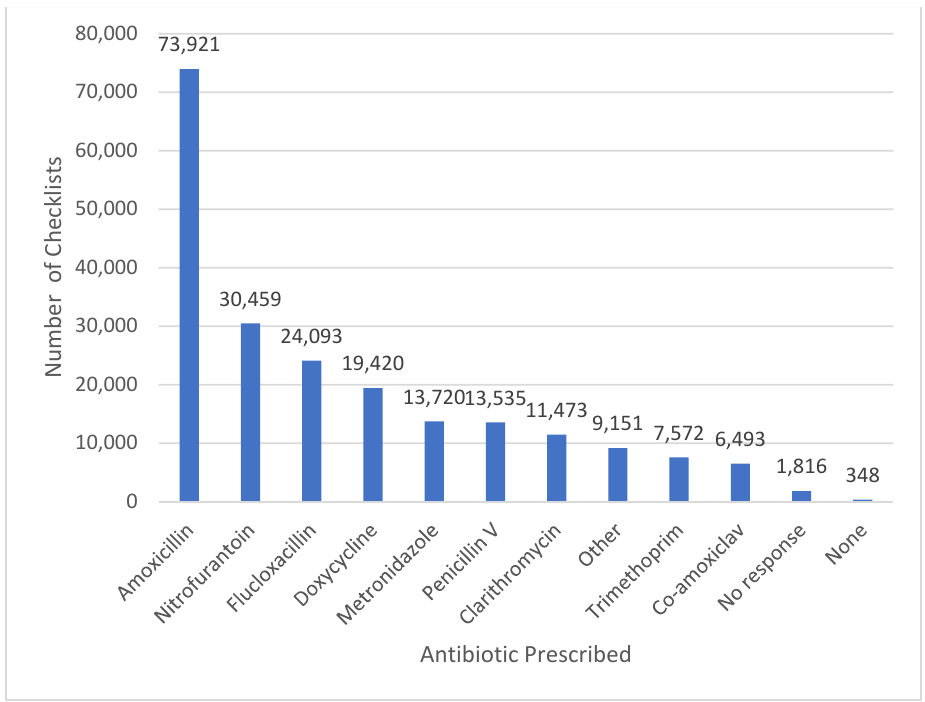
Figure 2. The frequency of antibiotics prescribed to patients for whom the TARGET Antibiotic Checklist was completed.